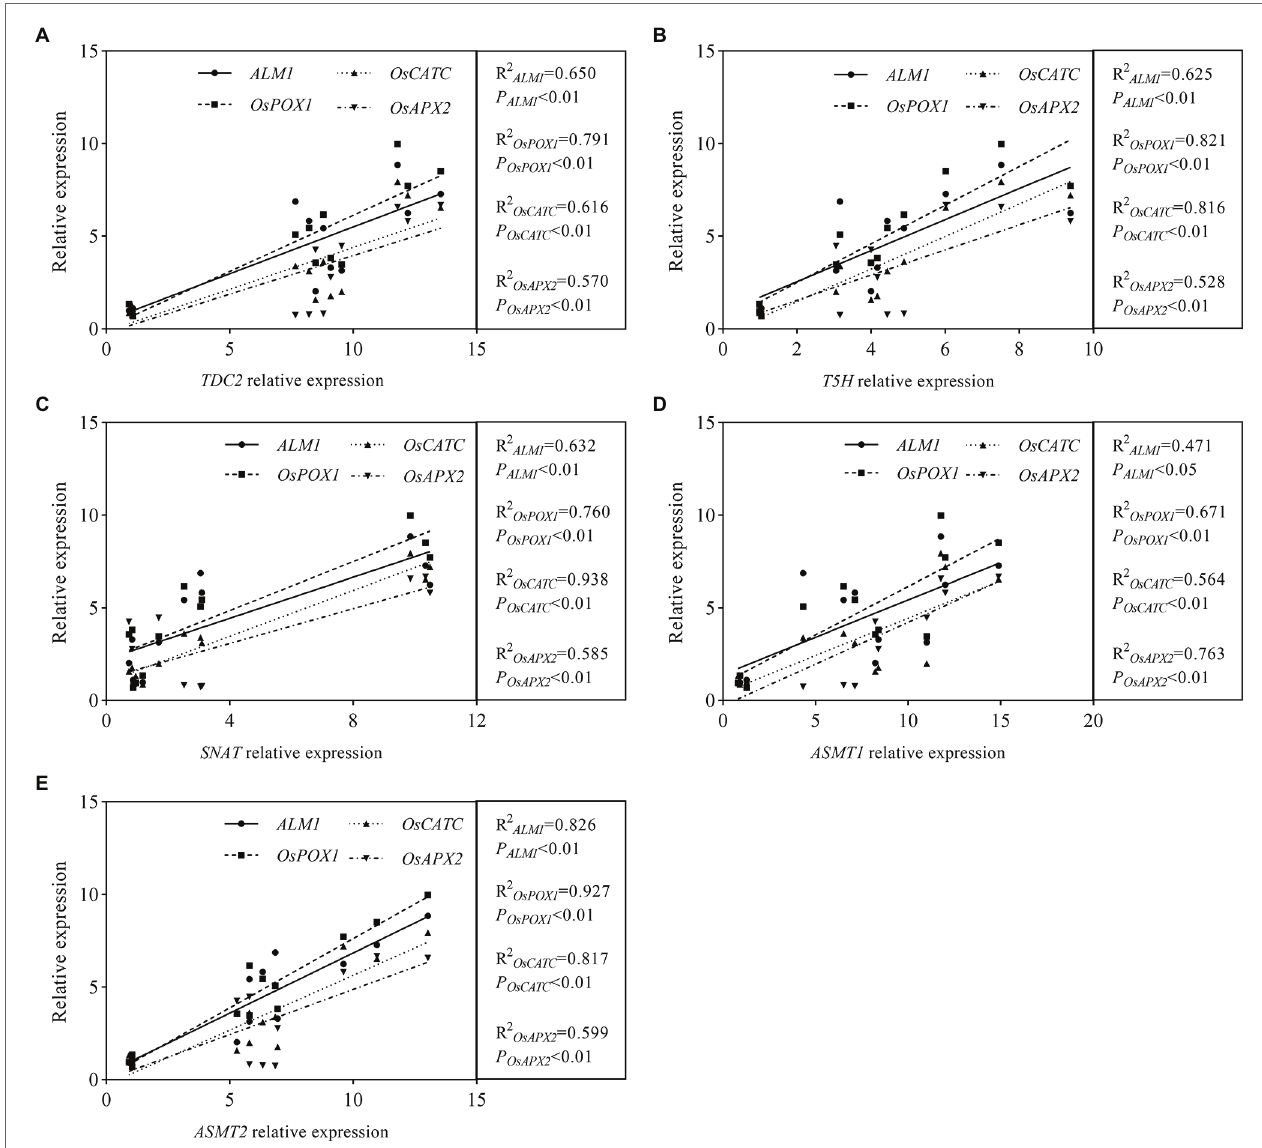
FIGURE 9 | Colinearity analysis of melatonin synthesis genes and antioxidase genes. (A) Colinearity analysis of TDC2 and antioxidase genes. (B) Colinearity analysis of T5H and antioxidase genes. (C) Colinearity analysis of SNAT and antioxidase genes. (D) Colinearity analysis of ASMT1 and antioxidase genes. (E) Colinearity analysis of ASMT2 and antioxidase